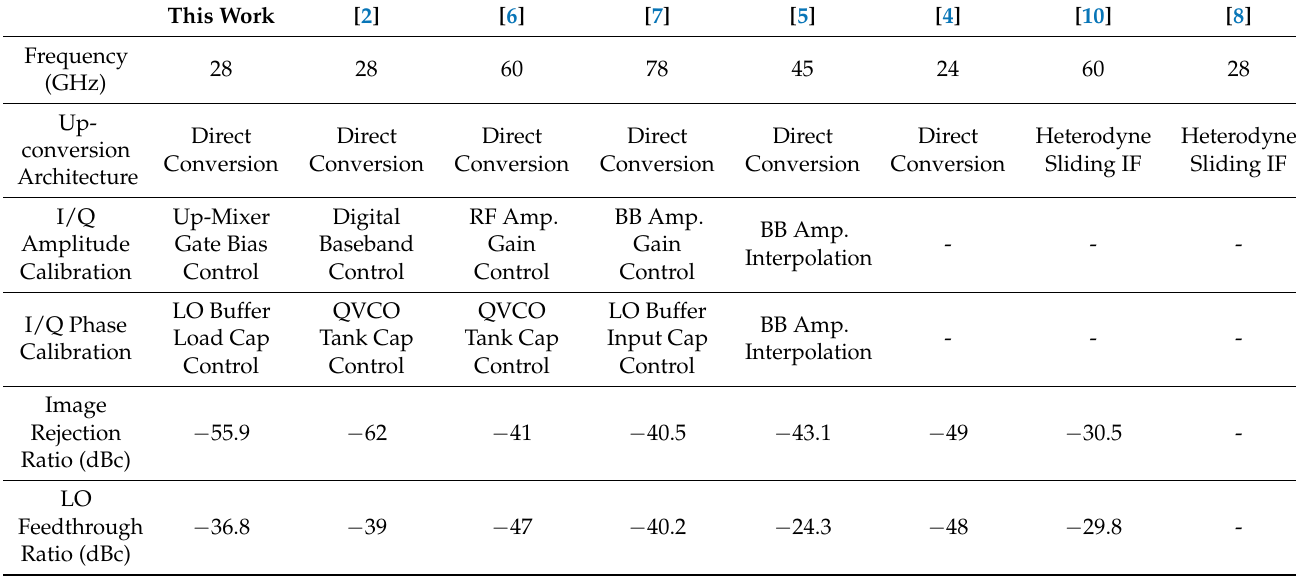
Table 1. Performance summary and comparison.